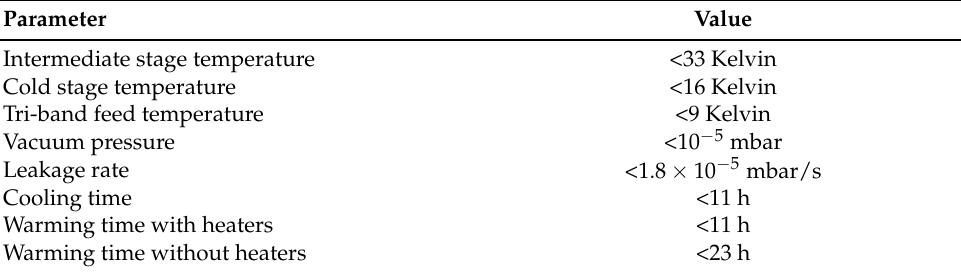
Table 1. Cryostat performance.